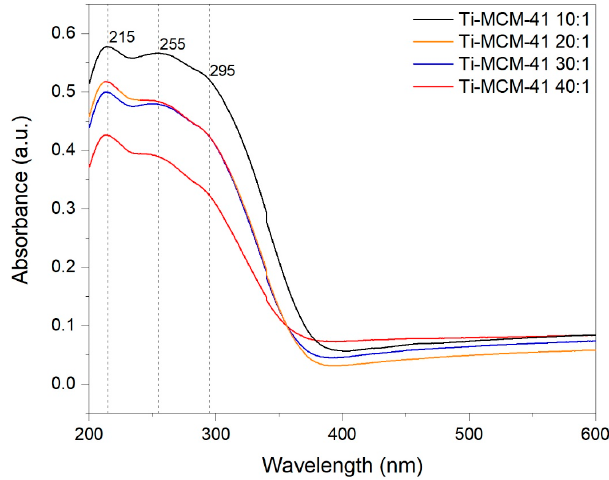
Figure 4. UV/Vis spectra of the Ti-MCM-41 catalysts with different molar ratios of Si:Ti in the crystallization gel (respectively, 40:1, 30:1, 20:1, and 10:1).